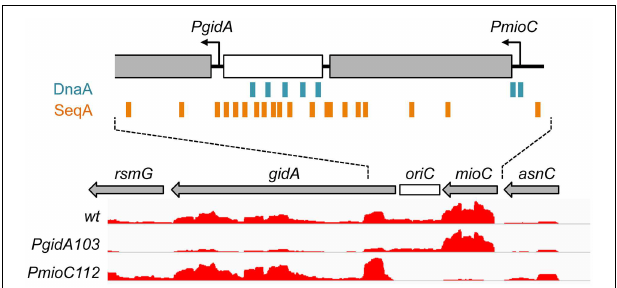
FIGURE 1 | Transcription in the oriC region. The minimal oriC (white box) and surrounding genes are shown, with transcription direction indicated by arrows. Binding sites for DnaA (blue boxes) and SeqA (orange boxes) overlap mioC and gidA promoters, respectively. Relative transcription in wildtype and gidA and mioC promoter mutants, as determined by RNA-sequencing is shown (height of red lines indicate relative reads per base